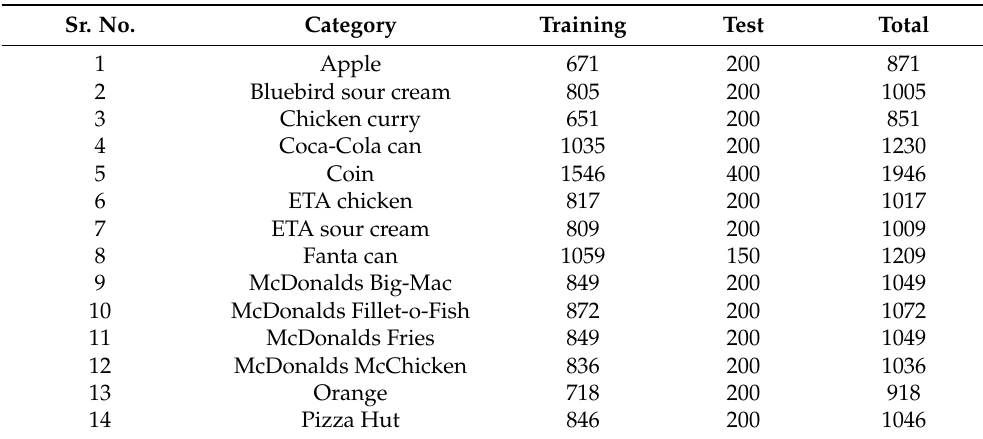
Table 1. Details of test and training